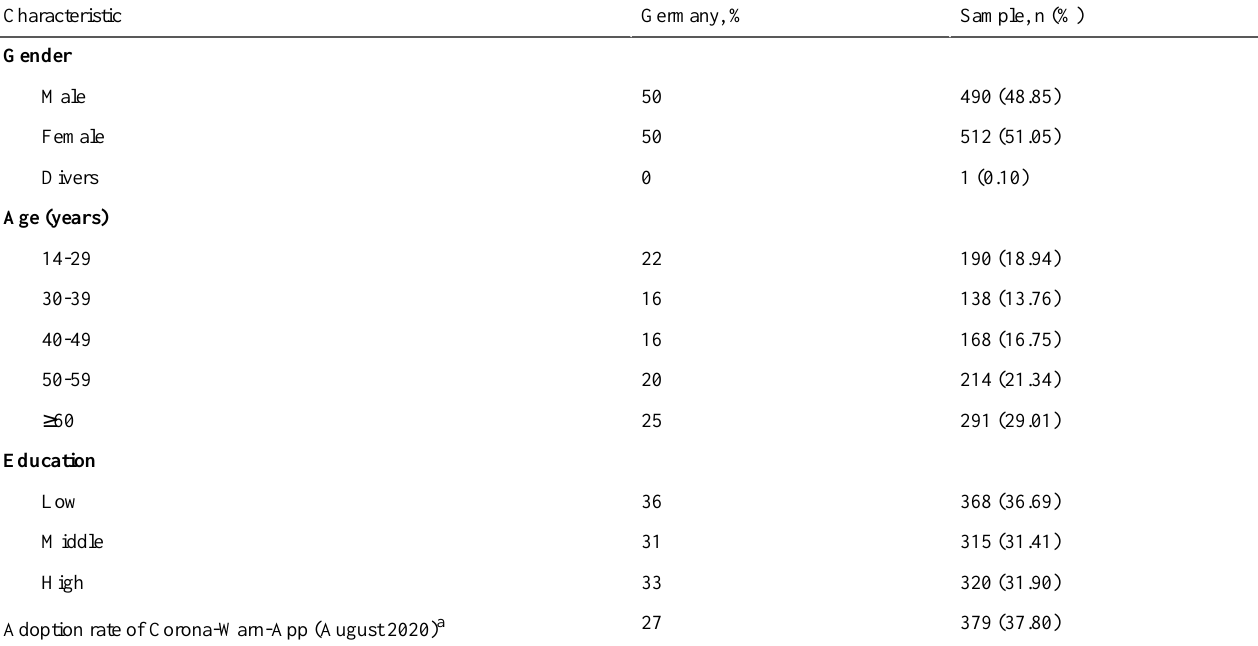
Table 2. Representativeness